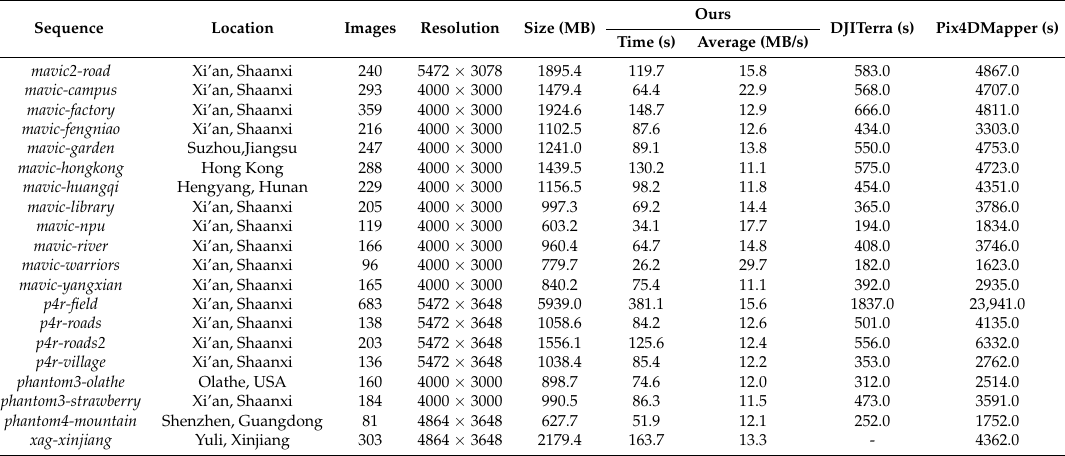
Table 1. Time usage statistics in seconds for processing sequences of DroneMap2 dataset. DJITerra failed to process sequence xag-xinjiang without any tips about the reason. The results show that our algorithm is much faster than other state-of-the-art commercial softwares.